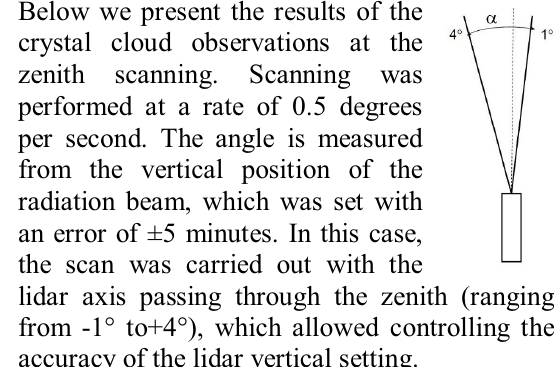
Fig. 1. Optical circuit of the lidar LOZA-M3